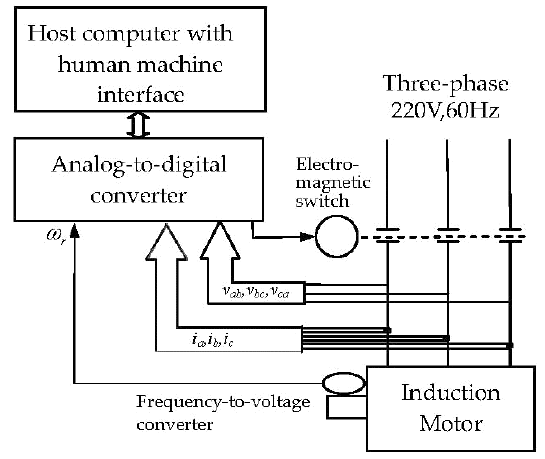
Figure 5. Schematic diagram of the field test.